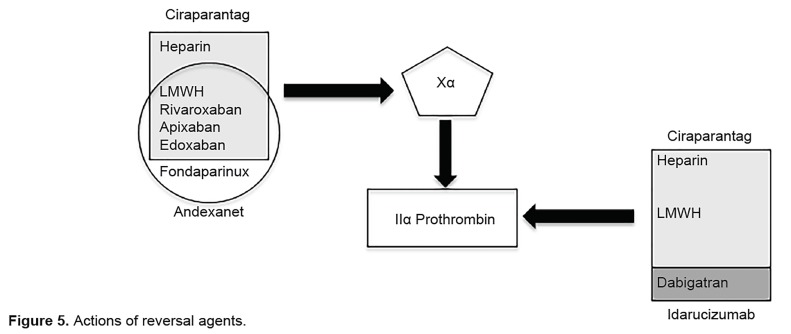
Actions of reversal agents.